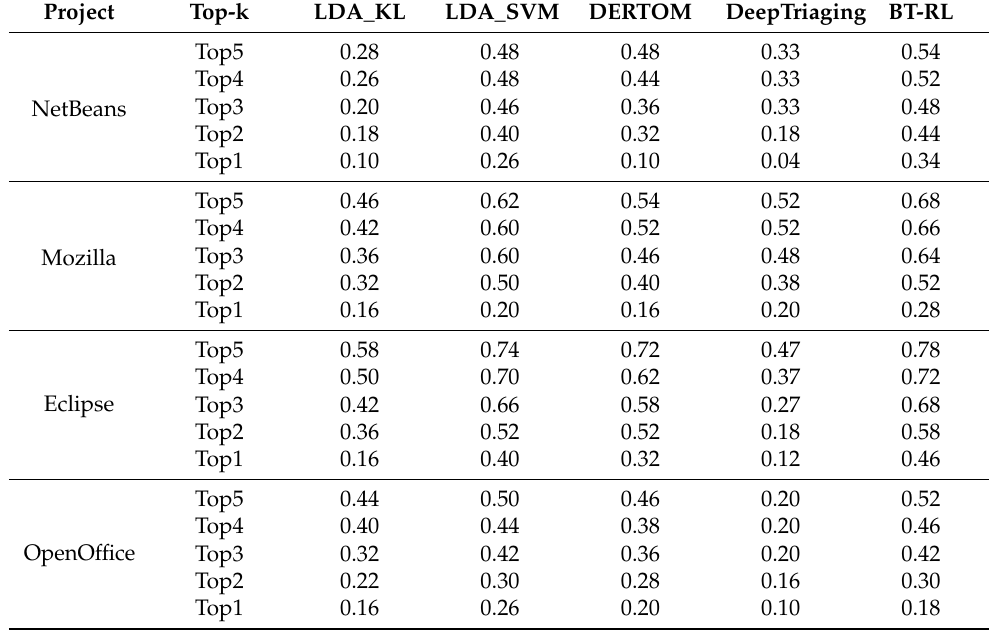
Table 3. The accuracy of BT-RL and other benchmarks on four projects of the first experimental window. Project